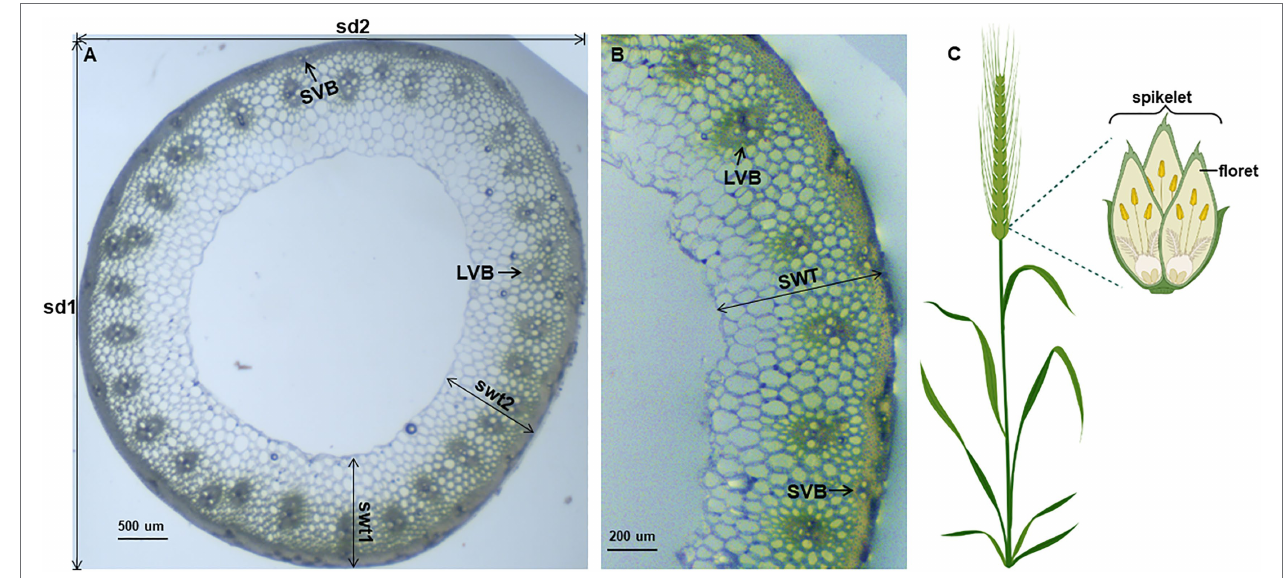
FIGURE 1 | Display of measured wheat characteristics. Anatomical characteristics of wheat stem (A,B) . The wheat stems are not that regularly round, so we measured the longest (sd1) and the shortest stem diameter (sd2), and the thickest (swt1) and the thinnest (swt2) stem wall for data collecting. LVB: large vascular bundles; SVB: small vascular bundles; SD: stem diameter; SWT: stem wall thickness. Wheat spikelet architecture (C) , created with